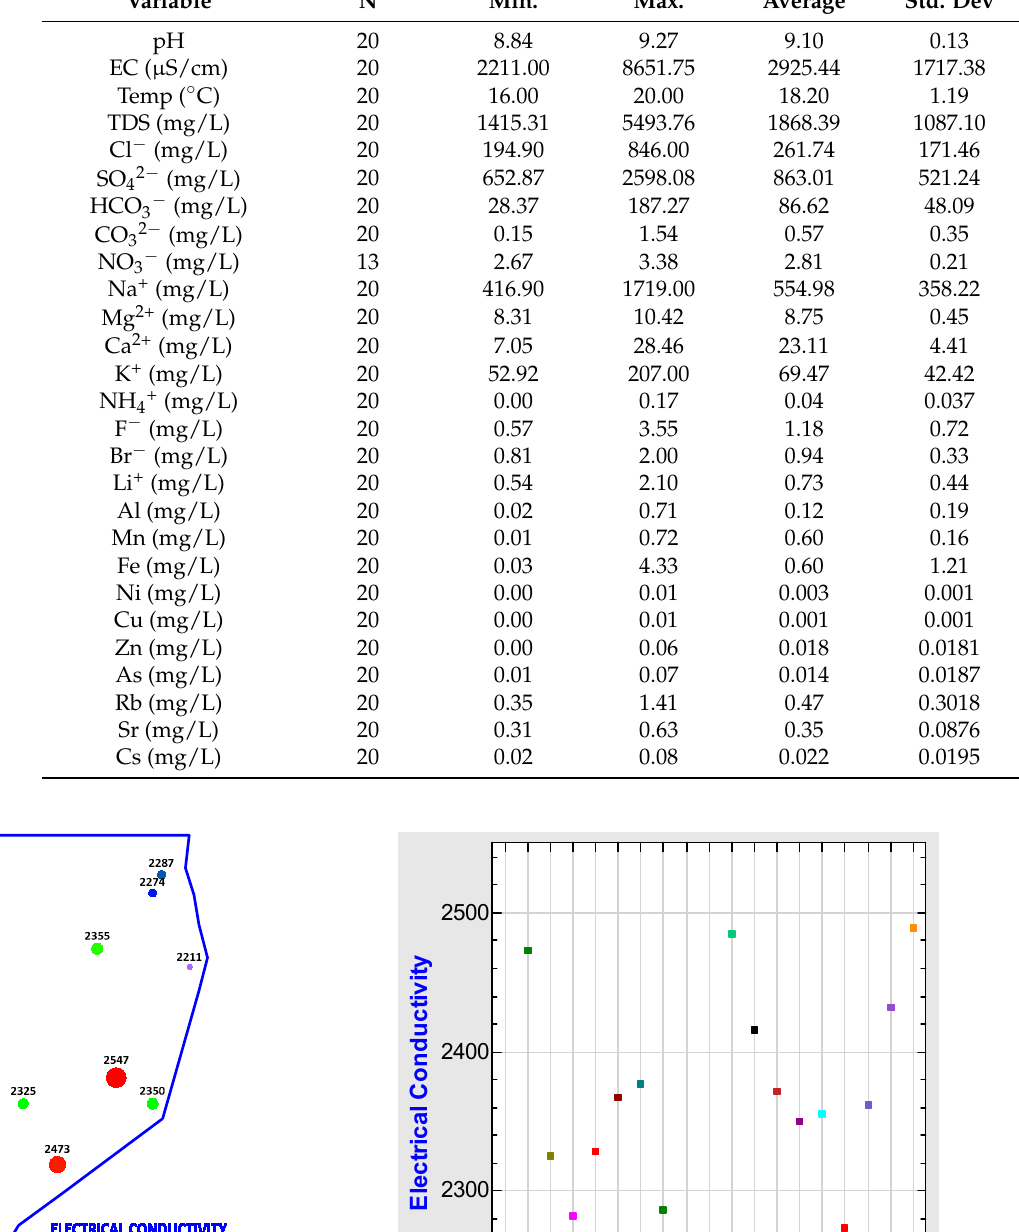
Table 2. Descriptive statistics of sampled variables in Sochagota Lake (N: number of samples; Min: minimum; Max: maximum; Std. Dev.: standard deviation).